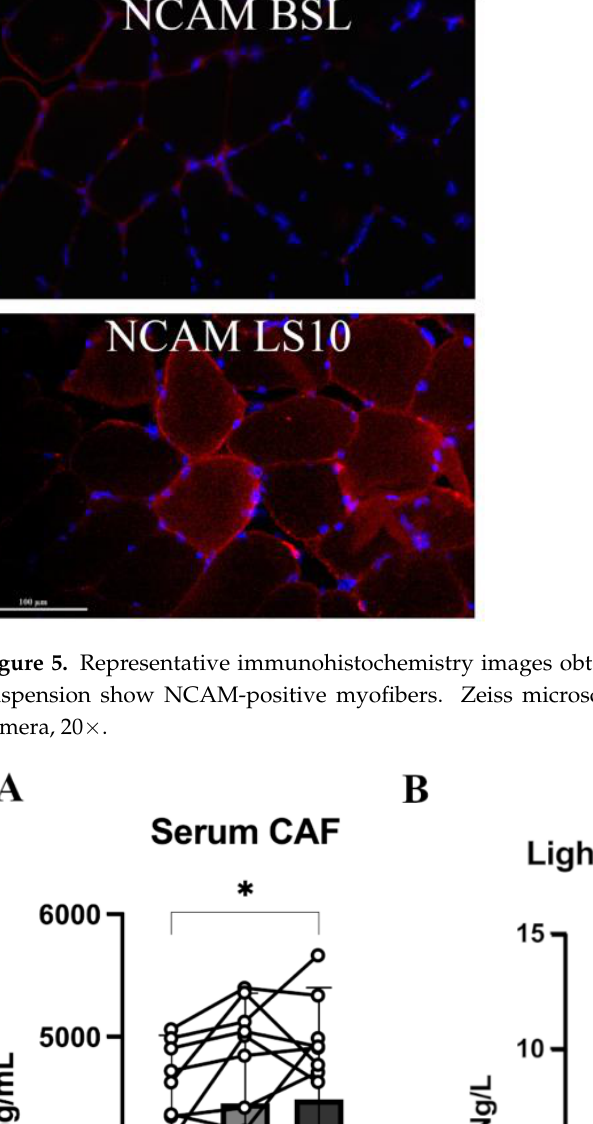
Figure 5. Representative immunohistochemistry images obtained at BSL and 10 days after limb sus- pension show NCAM-positive myofibers. Zeiss microscope connected to a Leica DC 300F camera, 20×.